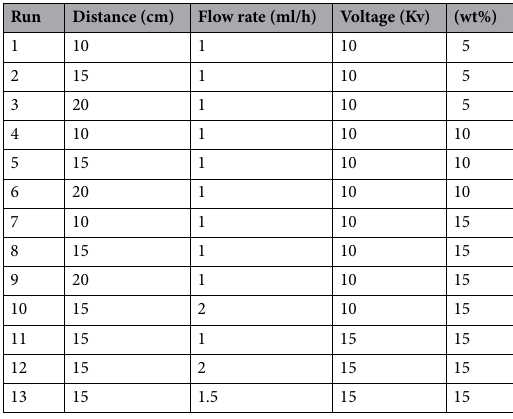
Table 2. PAN electrospinning in different operating